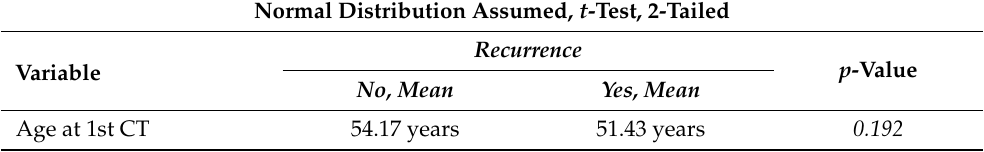
Table 3. Association between continuous numerical variables and stone recurrence, univariate analysis ( n = number). Boldface indicates statistically significant